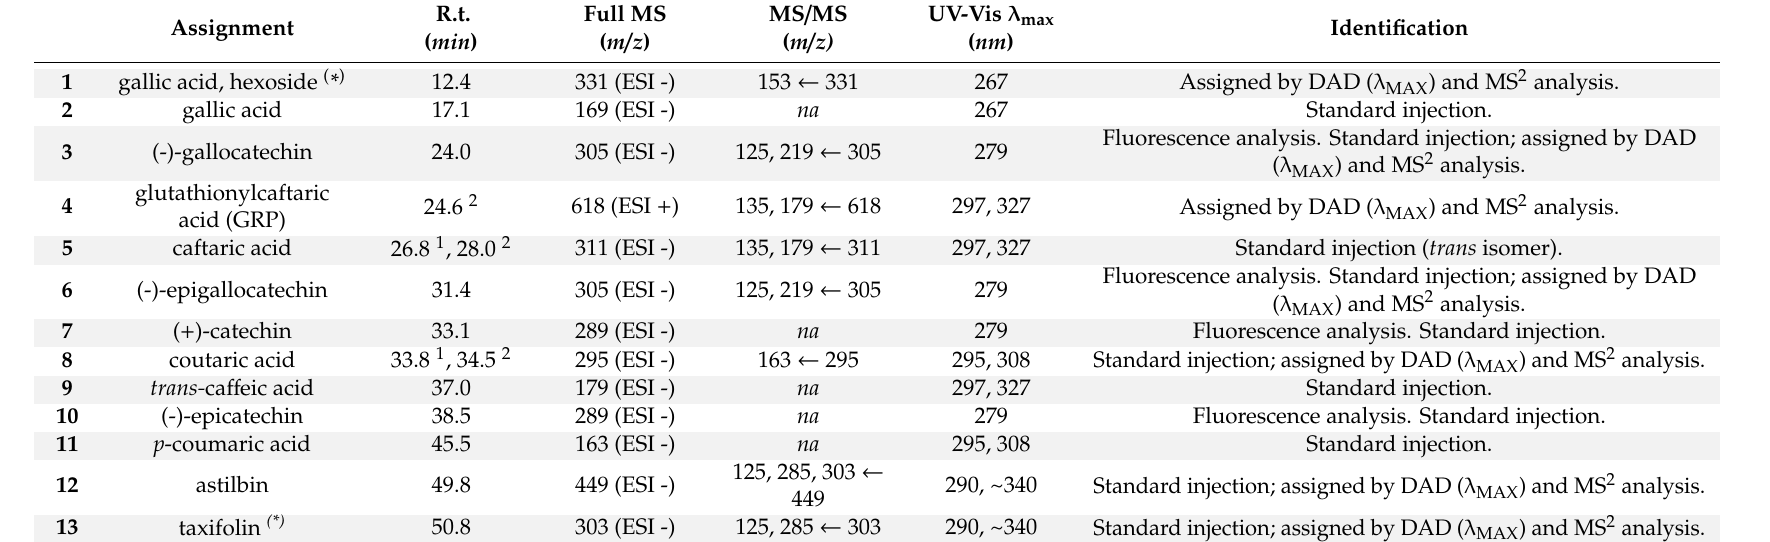
Table 2. Compounds identified by HPLC-DAD and HPLC-MS